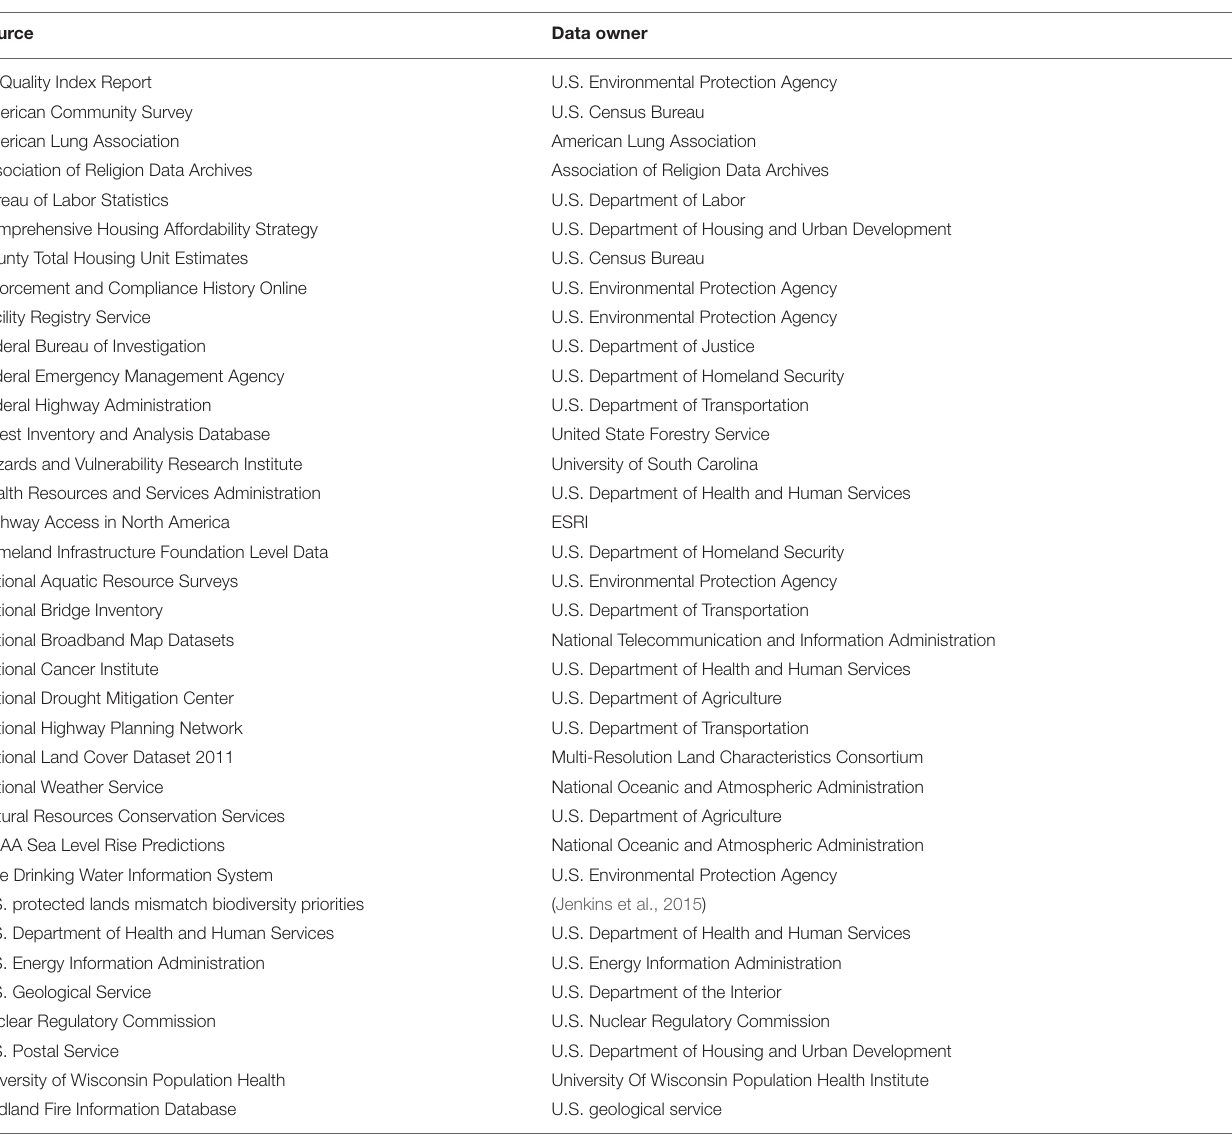
TABLE 3 | List of secondary data sources used in the CRSI indicator development